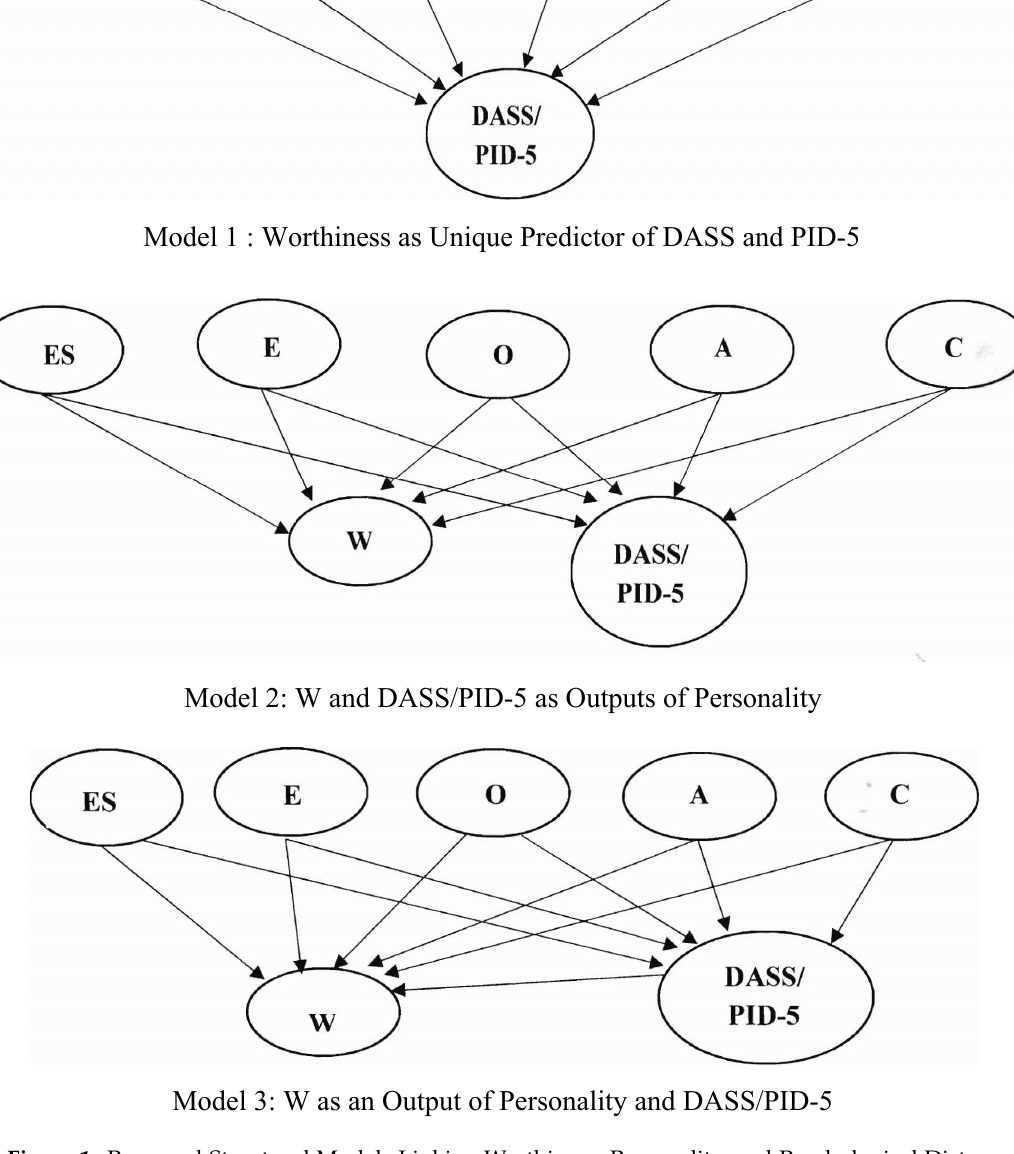
Figure 1. Proposed Structural Models Linking Worthiness, Personality, and Psychological Distress. DASS = Depression, Anxiety, and Stress Scale; PID-5 = Personality Inventory for DSM-5; W Worthiness; ES = Emotional Stability; E = Extraversion; O = Openness; A = Agreeableness; C = Conscientiousness.